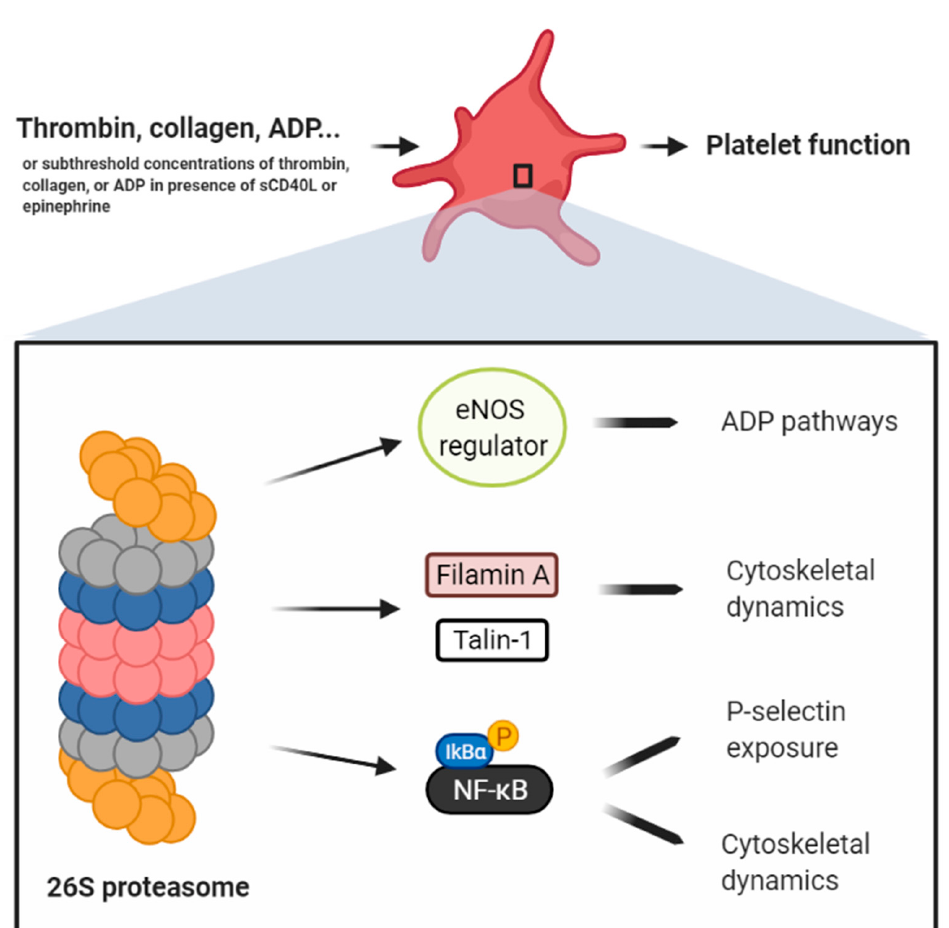
Figure 2. Schema compiling the data of different reports ascribing to the proteasome a positive regulatory role in platelets. Avcu et al. [129] claim that the platelet proteasome degrades eNOS regulators, thereby preventing the production of NO, an ADP receptor antagonist. Gupta et al. [104] showed that the proteasome, in response to the most potent platelet agonist thrombin, only partially regulates platelet function via the cleavage of cytoskeletal regulators, such as Filamin A and Talin-1. Karim et al. [131] reported that the platelet proteasome, in response to collagen or thrombin, only partially regulates platelet activation, P-selectin exposure, and aggregation, through the activation of NF- κ B. Grundler et al. [132] showed that the platelet proteasome, in response to collagen and via NF- κ B activation, only partially regulates platelet aggregation. Our group has shown that sCD40L primes platelets, but does not induce their aggregation, by activating platelet NF- κ B and inducing P- selectin exposure and dynamic cytoskeletal shape changes [133,134]. sCD40L/NF-kB mediate platelet activation and aggregation in response to low doses of thrombin or collagen [134]. Although further validation is required, the sum of these data corroborates that the platelet proteasome/NF- κ B dyad is a positive regulator of platelet priming, in which P-selectin exposure and dynamic cytoskeletal shape changes are enhanced. This intermediate platelet state eventually potentiates platelet activation and aggregation when additional subthreshold concentrations of platelet agonists are